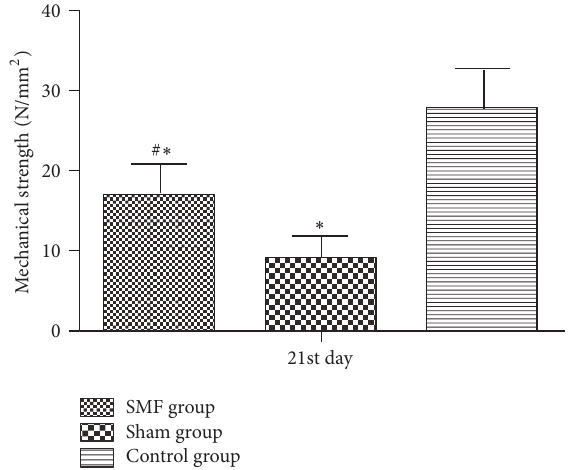
Figure 2: Comparison of mechanical strength in three groups on 21st day, # 𝑃 < 0.05 , statistically significant compared to the Sham group; ∗ 𝑃 < 0.01 , statistically significant compared to the Control group.